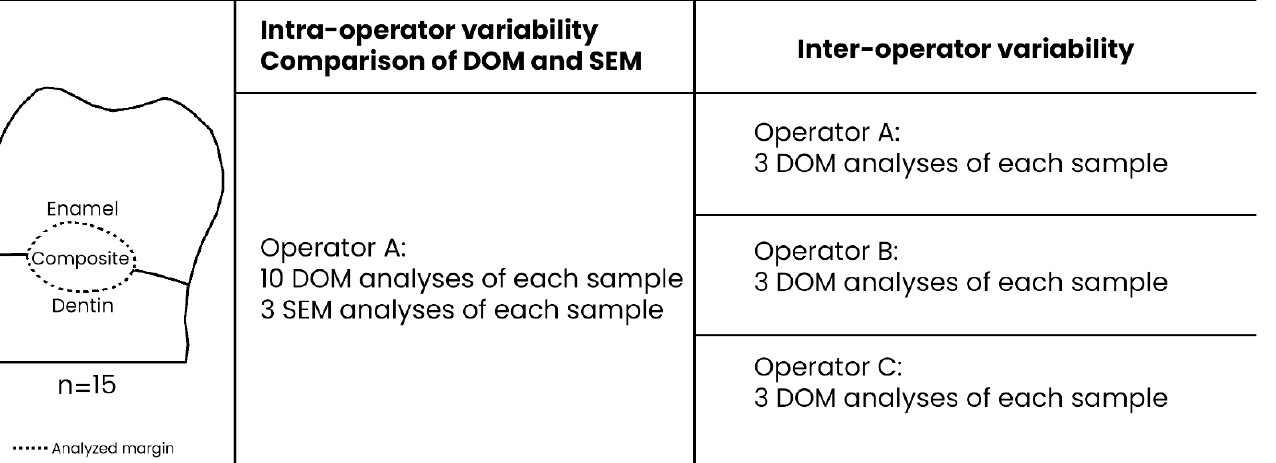
Figure 1. ( a ) Photograph of one the fifteen gold-coated tooth replicas with a class V composite res-